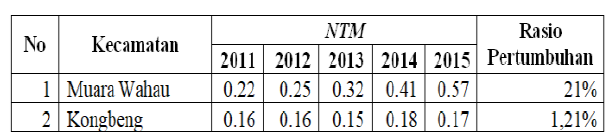
Table 3 . Exchange rates of community plasma plantations and company workers